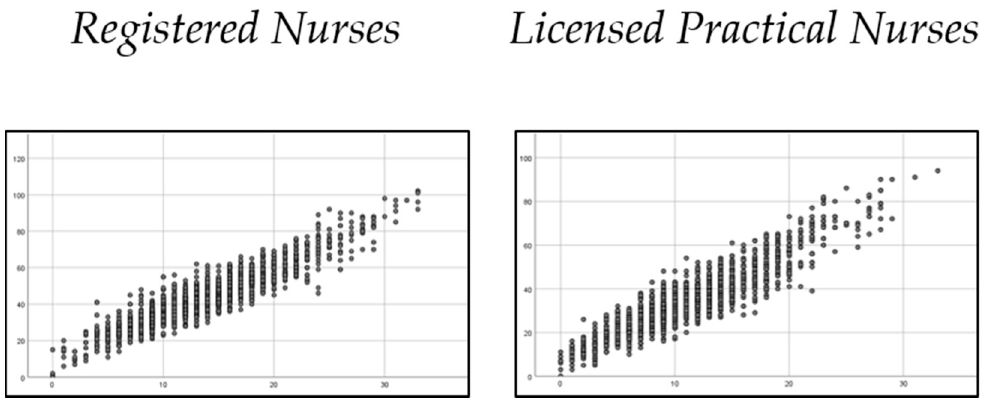
Figure 3. Scatterplot of sum score correlation between 34-item NSS (y-axis) and short-form NSS (x-axis) for registered nurses (RN) and licensed practical nurses (LPN).